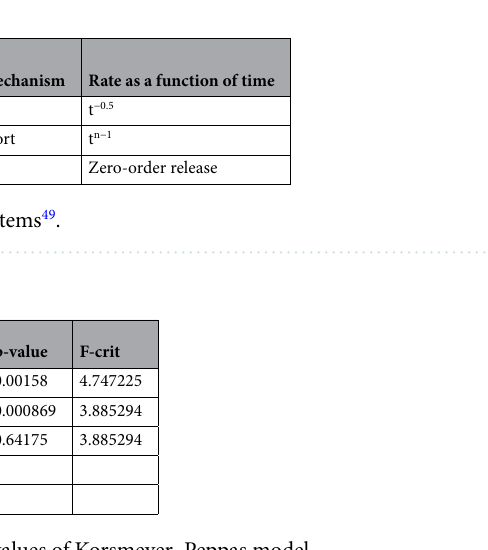
Table 3. Two-way ANOVA test for release constant values of Korsmeyer–Peppas